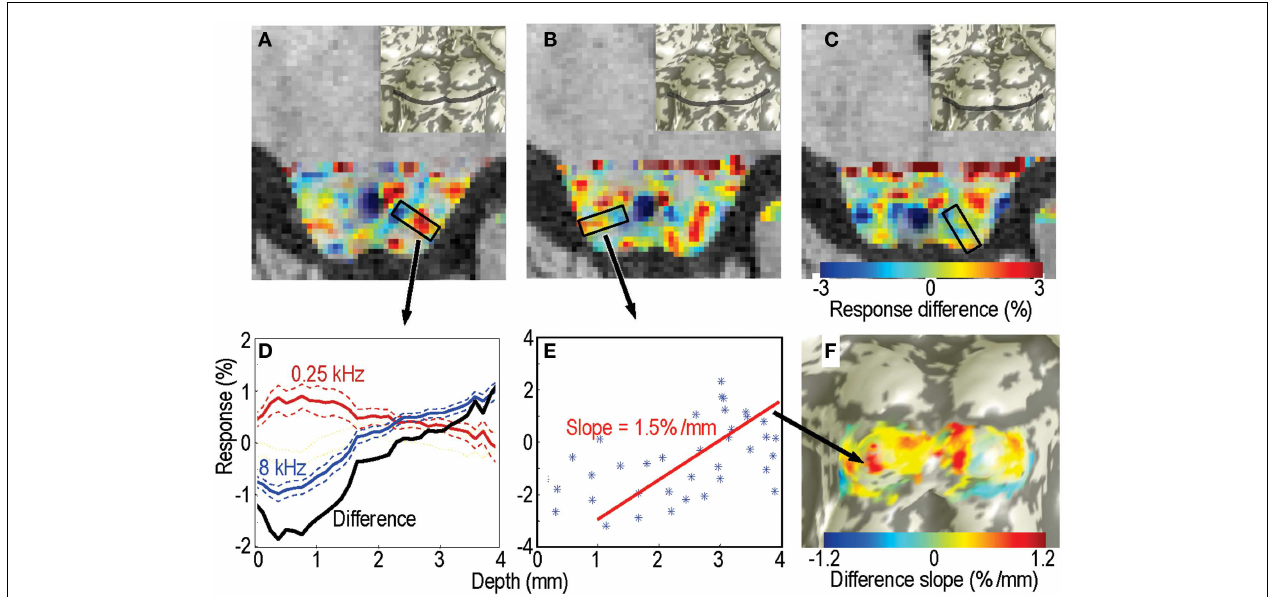
responses were obtained from a single depth penetration with a strong tonotopic gradient shown by the black rectangle in (A) .Thin dashed lines show 68% confidence intervals (e.g., SEM). (E) Response difference vs. depth for all voxels in another penetration marked in (B) . Red line is a linear fit the data beginning at 1-mm depth into the tissue. (F) The slopes of these linear fits are shown as a color overly upon this surface rendering of the subject’s IC.